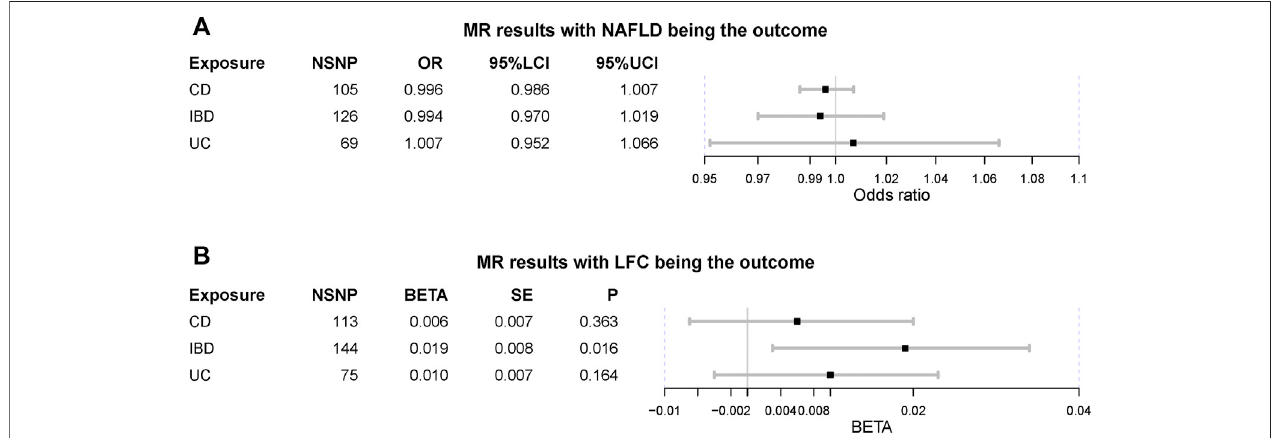
FIGURE 2 | Mendelian randomization (MR) results where non-alcoholic fatty liver disease and liver fat content as the outcomes. NAFLD is non-alcoholic fatty liver disease; LFC is liver fat content; CD is Crohn ’ s disease; IBD is in fl ammatory bowel disease; UC is ulcerative colitis; NSNP is the number of single nucleotide polymorphisms used in MR analysis; OR is odds ratio; 95% LCI is the lower limit of 95% con fi dence interval of OR/BETA; 95% UCI is the upper limit of 95% con fi dence interval of OR/BETA; SE is standard error; P is the p -value of OR/BETA. BETA is for the continuous variable LFC.